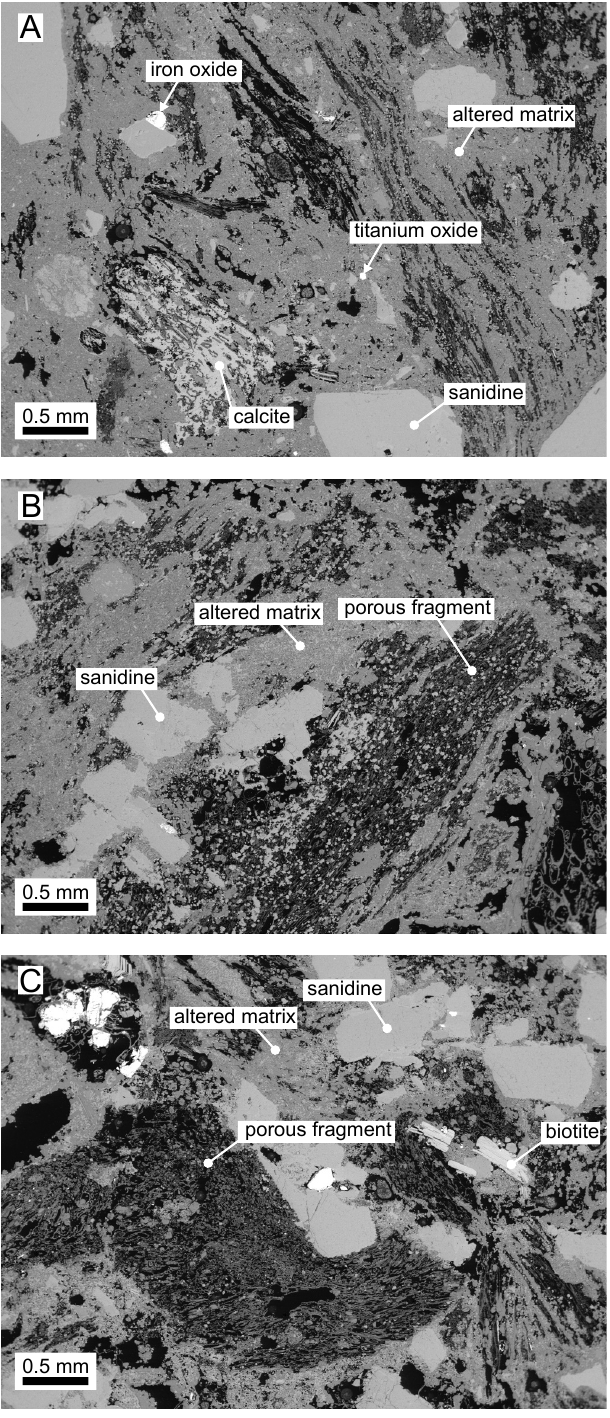
Figure 3: Backscattered scanning electron microscope images of “as collected” (i.e. material that has under- gone no heating or deformation) Mt. Epomeo Green Tu ff